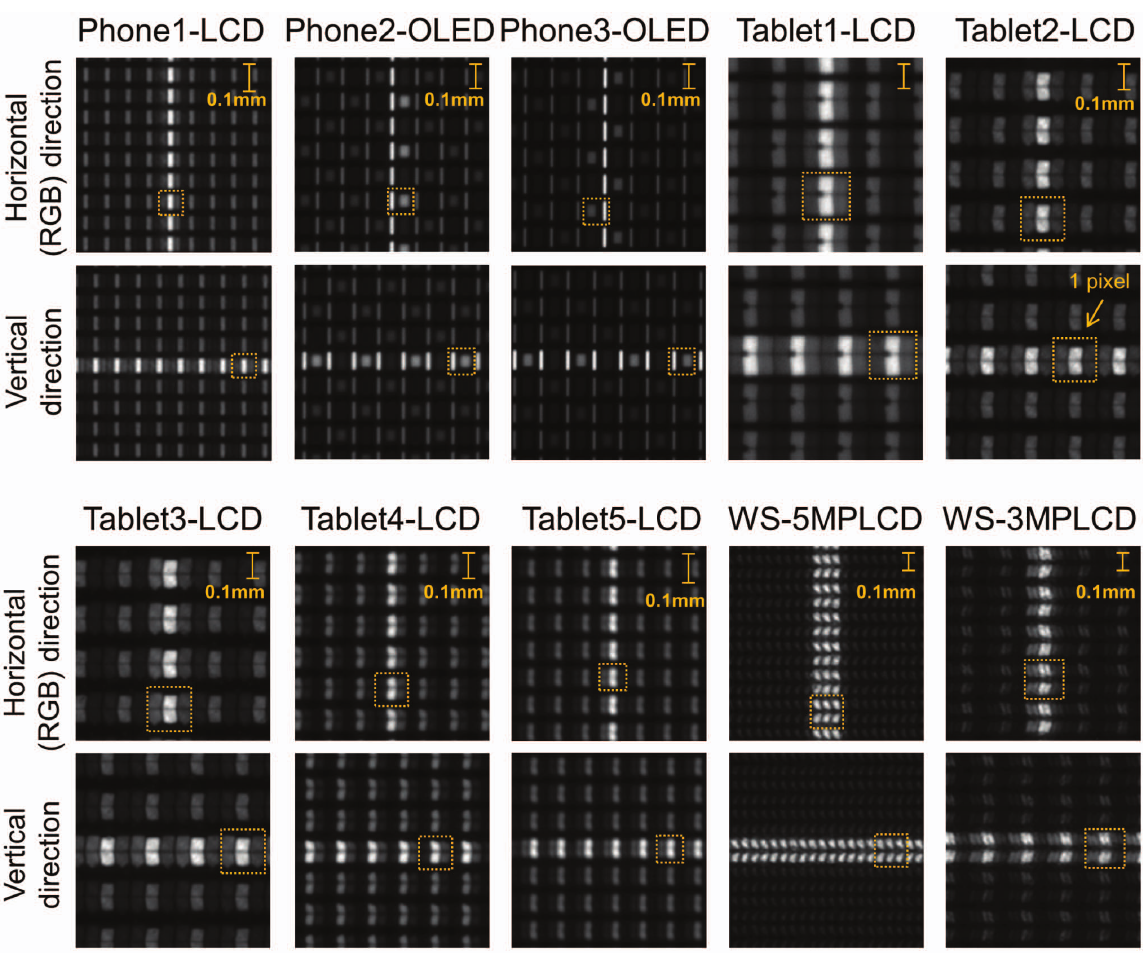
Figure 3. Display pixel structure. The screen displaying the 1-pixel line pattern was captured by the photometric camera. Since these image are not exactly in the same scale, 0.1-mm scale bars are indicated. Squares bounded by orange dot lines show the one pixel region of the displays. The vertical lines reflect the horizontal resolution characteristics corresponding to the RGB direction.